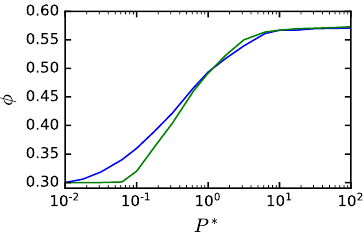
Figure 1. Isotropic compression curve for initial low (blue) and larger (green) coordination number (obtained with small or large initial kinetic energy in aggregation process).